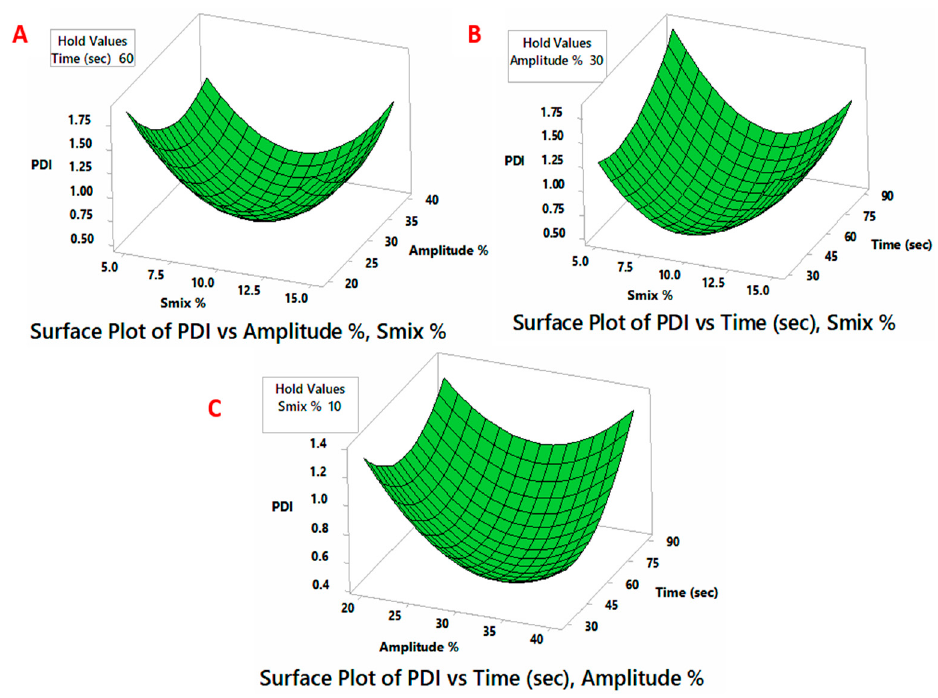
Figure 2. Diagrams of surface response demonstrating the impact of processing parameters on pol ‐ ydispersity index (PDI). ( A ) Impact of % S mix and amplitude % on PDI; ( B ) Impact of % S mix and sonication time on PDI; ( C ) Impact of time of % amplitude and sonication time on PDI.